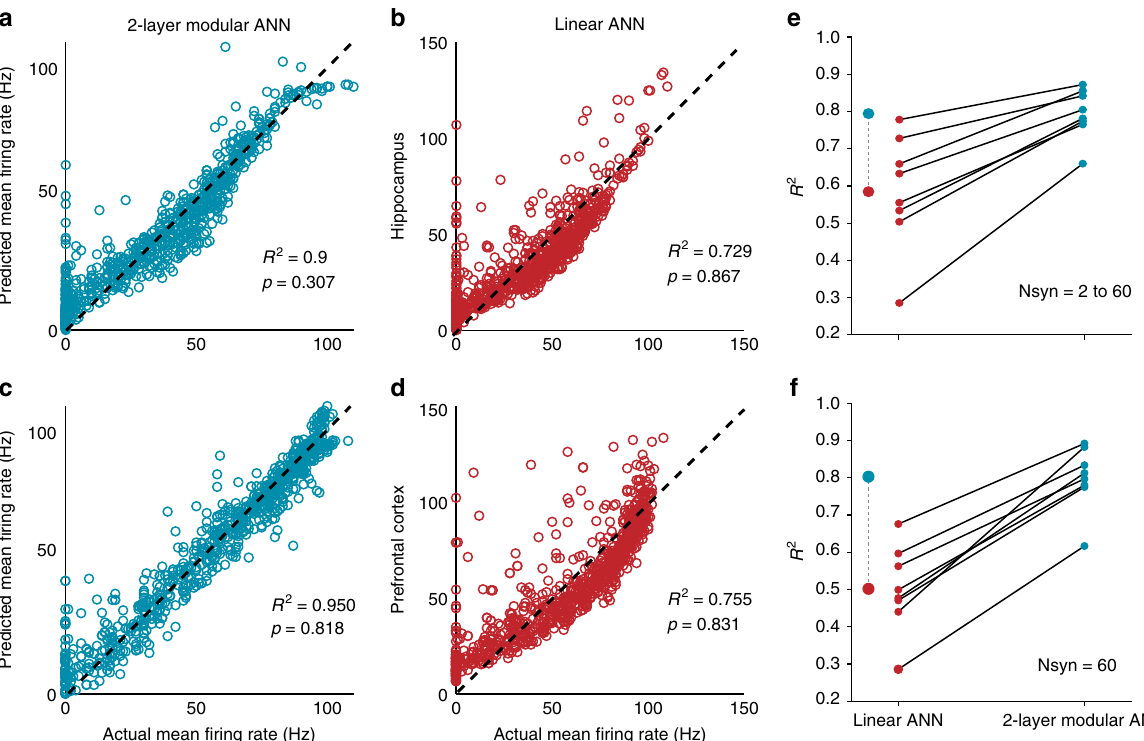
Fig. 6 Challenging the point neuron dogma: FS basket cells as two-stage nonlinear integrators. Linear regression analysis for two-layer modular ( a , c ) and linear ( b , d ) ANNs for one indicative hippocampal (top) and one indicative PFC (bottom) model cell. Actual mean fi ring rates (Hz) correspond to the responses of the compartmental model when stimulating with 50 Hz Poisson spike trains varying numbers of synapses (1 – 60), distributed in several ways (grouped or dispersed) within both sub- and supra-linear dendrites. Expected mean fi ring rates (Hz) are those produced by the respective ANN abstraction when receiving the same input (number of stimulated synapses) in its respective sub-/supra- or linear input layer nodes. e Regression performance (measured as R 2 ) for two-layer modular (right) and Linear (left) ANNs for all eight FS BC model cells, respectively. In all cases the two-layer modular ANN is superior to the Linear ANN. Mean R 2 values over all cells for the Linear (red) and two-layer modular (cyan) ANNs are shown on the left. f Same as e , applied to datasets comprised of 60 input synapses. The difference in performance between the two ANN types is higher in this challenging